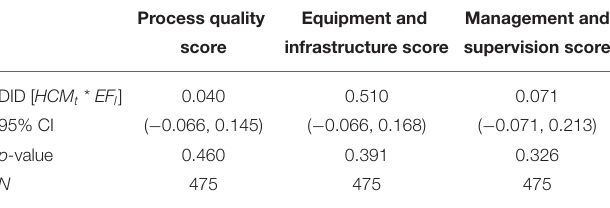
TABLE 15 | Falsification